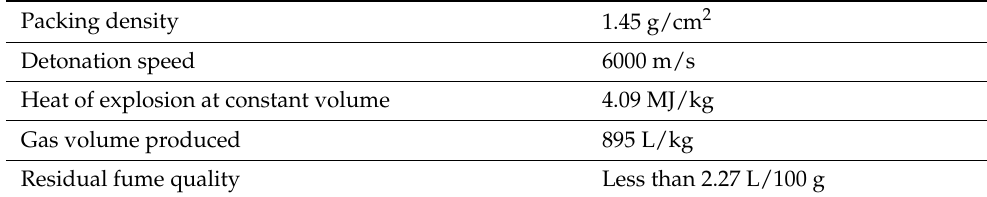
Table 3. RIODIN main